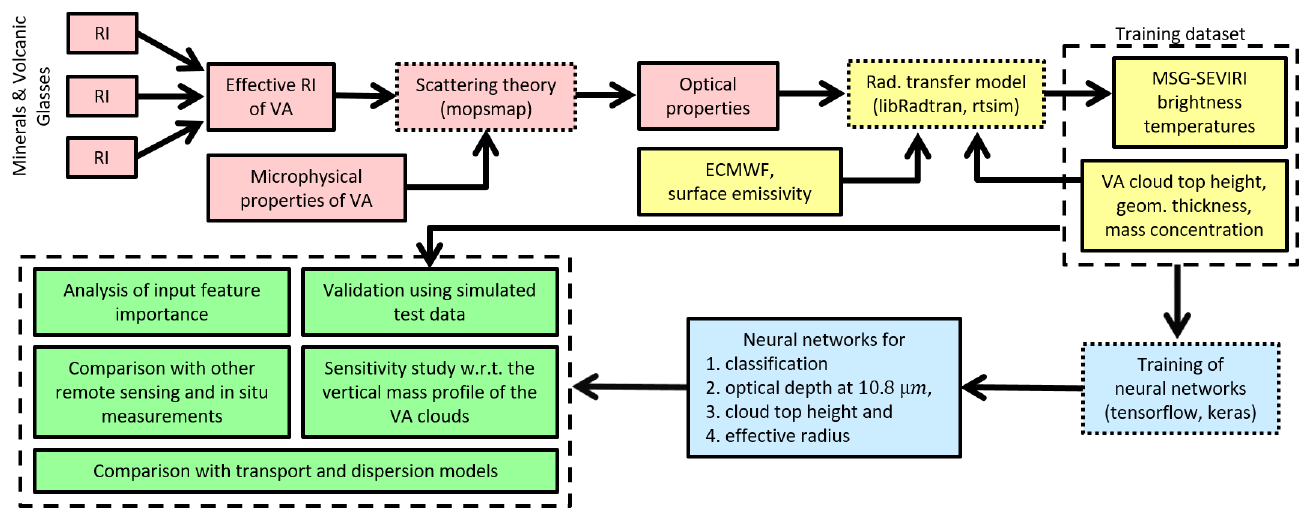
Figure 1. Scheme of the algorithm development and validation: (red) calculation of typical refractive indices (RIs) of volcanic ashes (VAs) and the corresponding optical properties [23], (yellow) radiative transfer calculations to compose a training dataset and (blue) training of different ANNs (both in this paper) and (green) validation against simulated test data and other independent measurements and model results